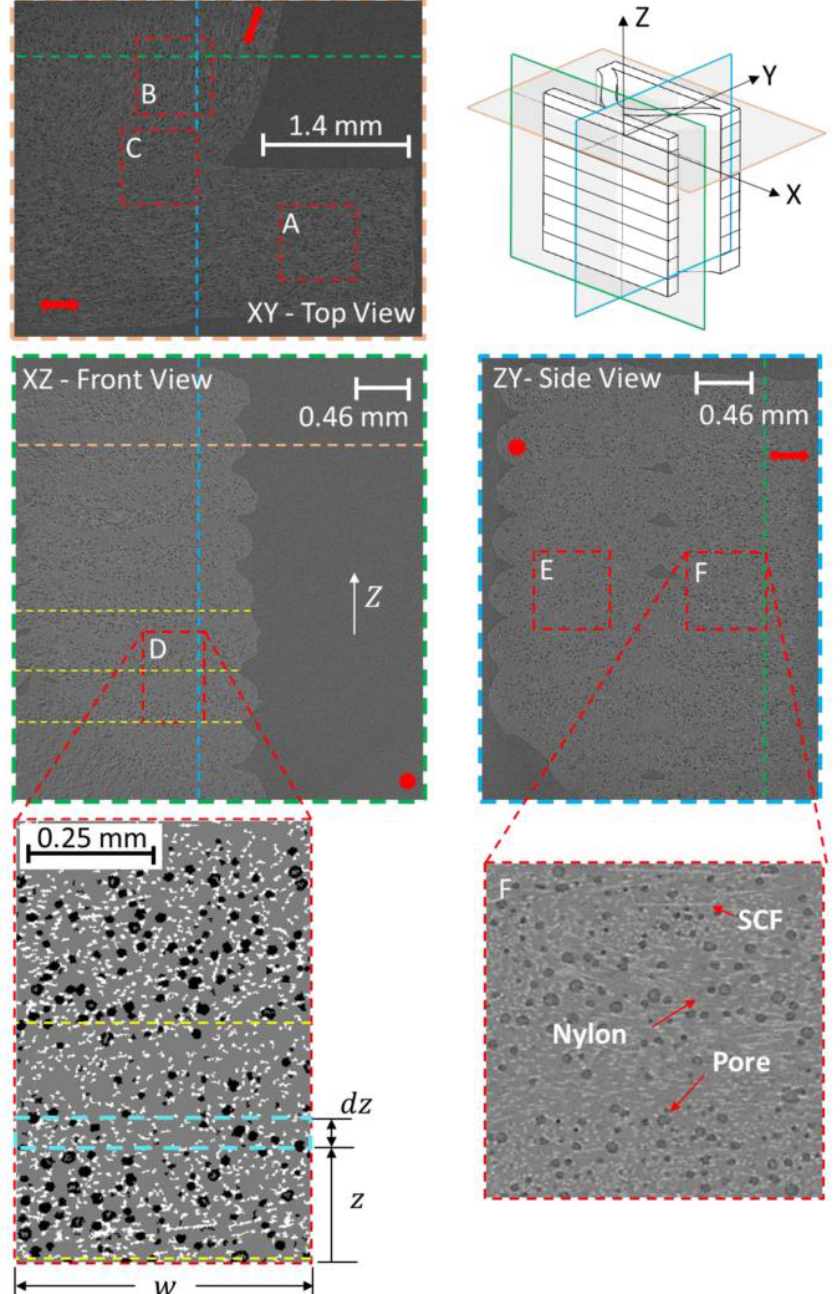
Figure 18. Top, front, and side cross-sectional views and isometric view of CT of MEAM-produced SCF parts. Blue, orange, and green dotted lines and colors represent cross-sectional views of MEX layers and straight and curved raster lines. Red dotted boxes are ROIs (Regions Of Interests) that will be analyzed using a mixed skew-Gaussian distribution (MSGD). The XY view shows the intersection of a straight and curved raster with three ROIs: A—the straight raster, B—the curved raster, and C—the intersection zone. The XZ view shows the MEX layer stacking and the porosity distribution across the layer interface using ROI D with the porosity distribution determined in w x ∆ z areas along the Z-direction. The ZY view shows the side cross-section of the straight (ROI E) and curved (ROI F) regions